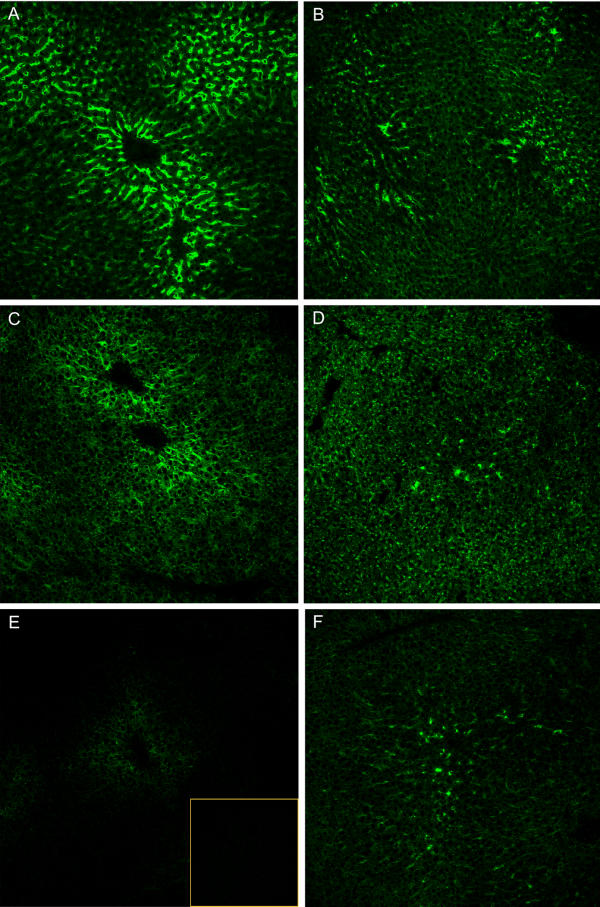
Distribution of bovine LPL in livers at different times after injection, and the effect of heparin. Tissue sections were stained with the rabbit polyclonal anti-LPL IgG and then with goat anti-rabbit IgG labelled with Alexa fluor 488 (green). Panels A, C and E are from rats that did not receive heparin. Panels B, D and F are from rats that had been given heparin five min before the injection of active bovine LPL. Panels A and B are two min, panels C and D are 15 min, and panels E and F are 60 min after injection of the lipase. The inset in panel E shows a section from the liver of a rat that was not injected with bovine LPL. The magnification was × 20.